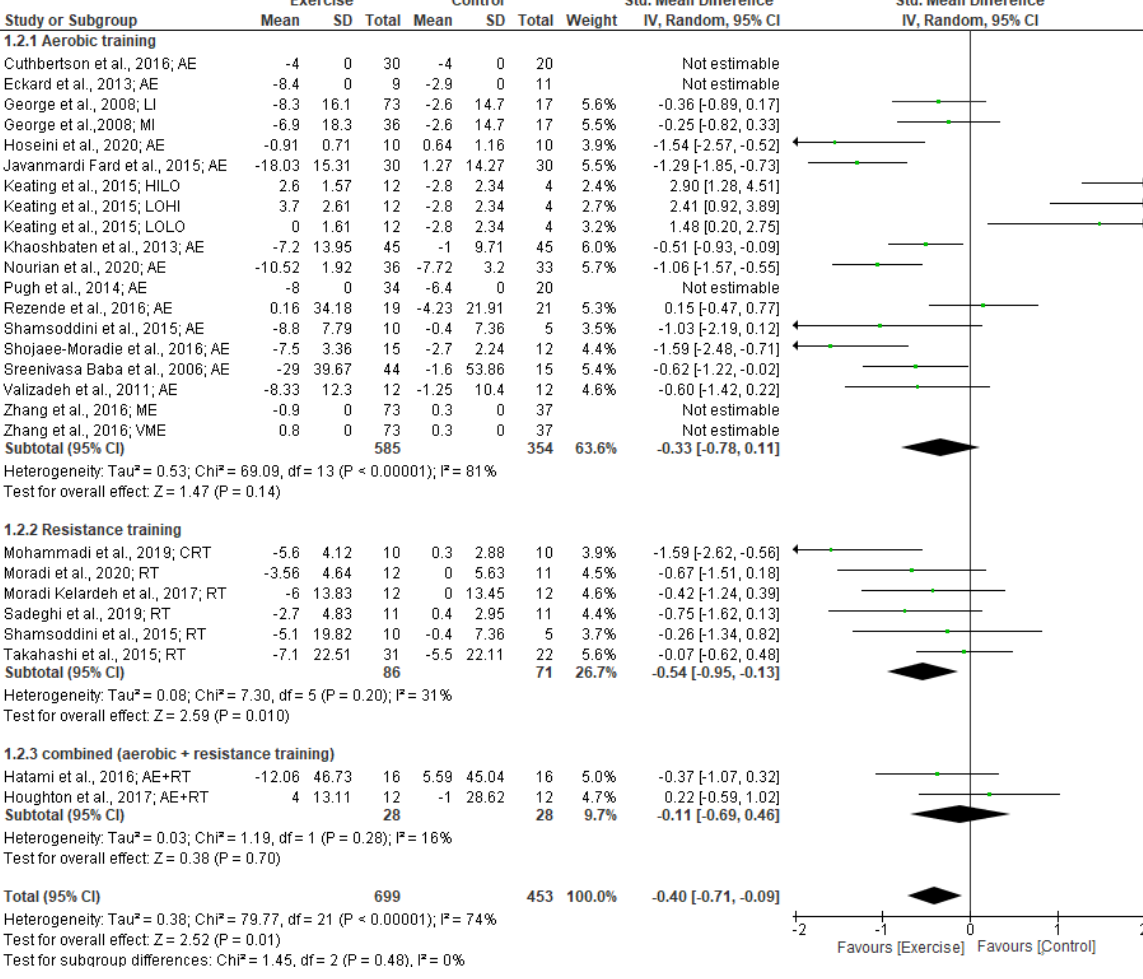
Figure 3. Forest plot showing study precision against the mean difference effect estimate with 95% confidence interval for AST [28–42,44–49,51].